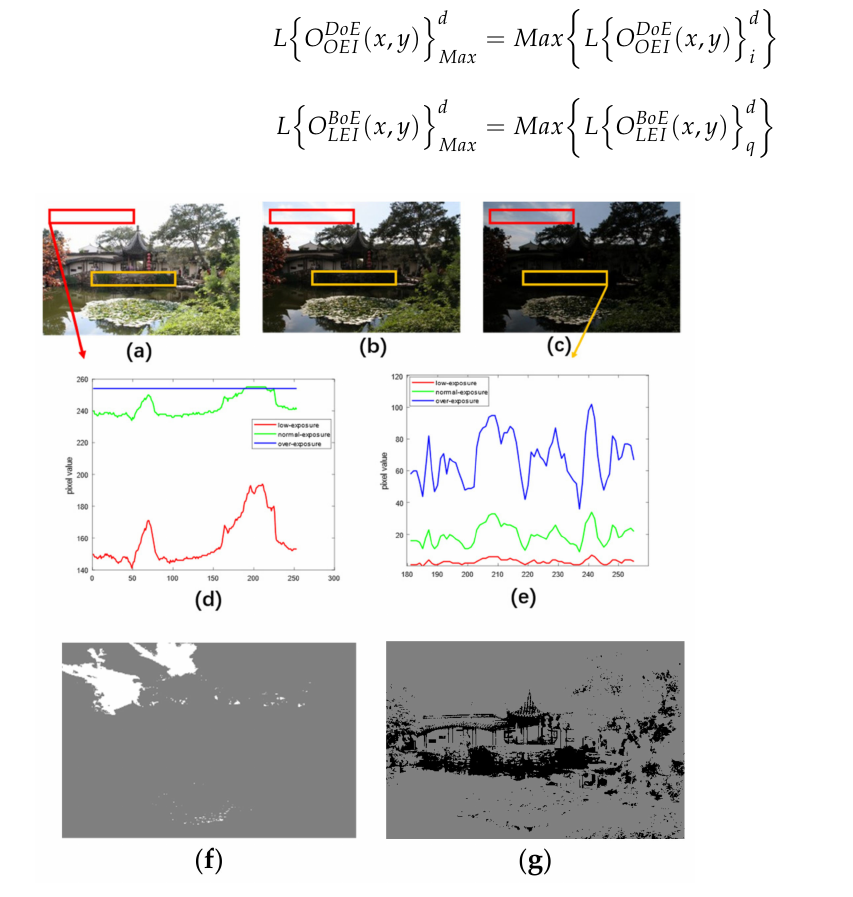
Figure 8. Analysis of areas of interest. ( a ) Over-exposed image. ( b ) Normal-exposure image. ( c ) Low-exposure image. ( d ) Pixel intensity analysis of the red region in ( a – c ). ( e ) Pixel intensity analysis of the yellow area in ( a – c ). ( f ) Brightest area. ( g ) Darkest